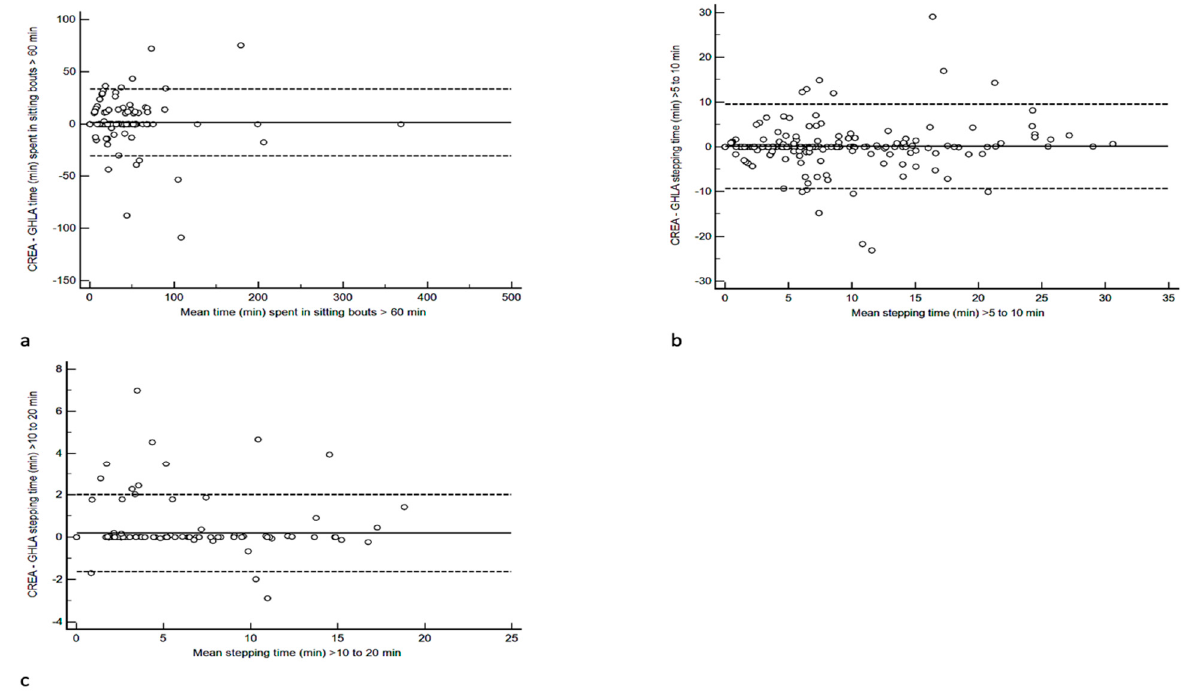
Figure 2. Bland–Altman plots comparing the outcomes provided from the CREA and GHLA algo- rithms for ( a ) time (min) spent in sitting bouts > 60 min, ( b ) stepping time (min) > 5 to 10 min, and ( c ) stepping time (min) > 10 to 20